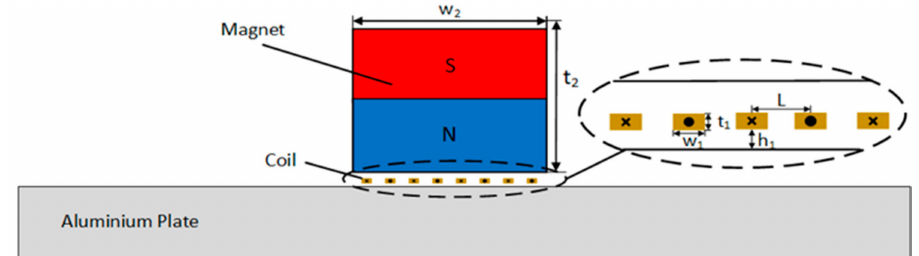
Figure 2. Two-dimensional (2-D) physical model of the surface wave EMAT.